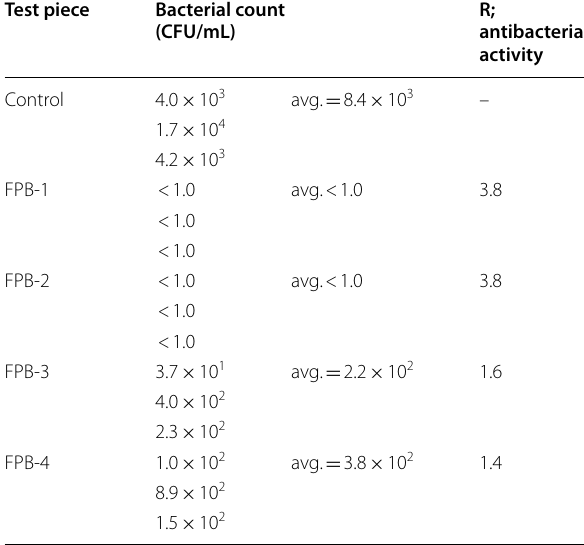
Table 2 Results of antibacterial property test for E. coli